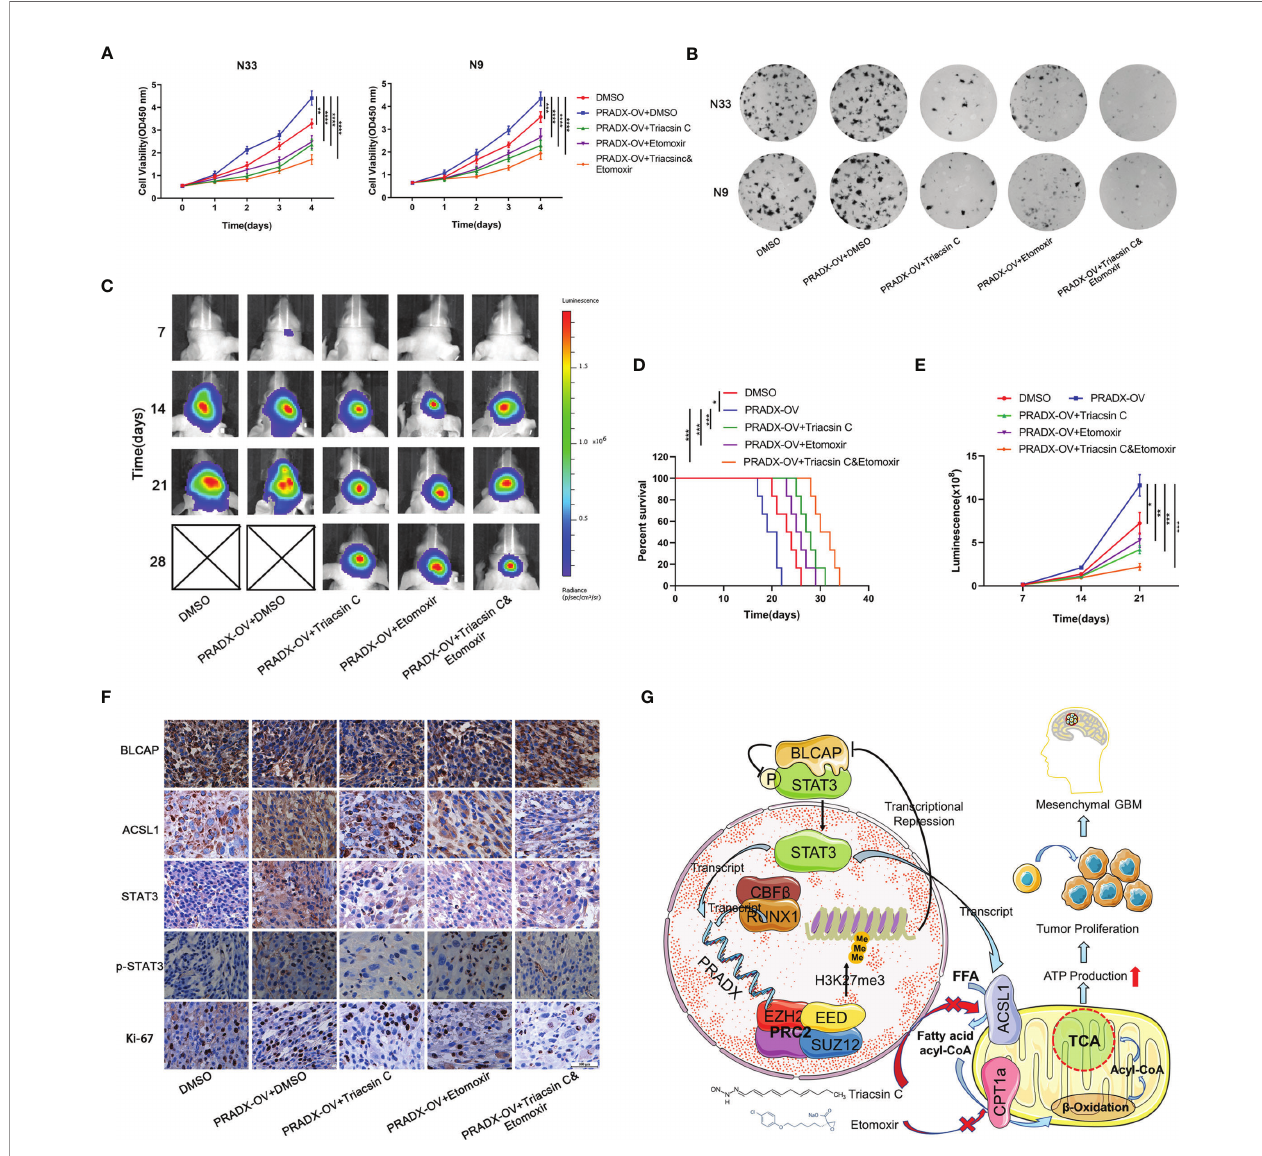
FIGURE 7 | Triacsin C and Etomoxir reduce PRADX-mediated tumorigenesis in vitro and in vivo . (A) CCK8 assays show the effect of PRADX overexpression and the Triacsin C and Etomoxir on cell viability. (B) Colony formation assays show the effect of PRADX overexpression and the Triacsin C and Etomoxir on the tumor cell growth of the indicated fi ve groups, representative images are shown. (C) Nude mice were orthotopically injected with PRADX overexpression or scramble TBD0220 cells. Representative luminescence images at 7,14,21 and 28d after injection are shown. (D, E) Kaplan-Meier survival curve and quanti fi cation of bioluminescence signal intensities at 7,14, and 21d post-injection are shown. (F) IHC of tumor tissues from nude mice xenograft models showing BLCAP, ACSL1, STAT3, p-STAT3, and Ki-67 expressions in the fi ve groups. (G) Scheme showing PRADX-EZH2 interaction-mediated recruitment of H3K27me3 and regulation of STAT3 activity, promoting mesenchymal GBM tumorigenesis. The values in A are represented as mean ± SD (n = 3). *P < 0.05, **P < 0.01, ***P < 0.001, ****P